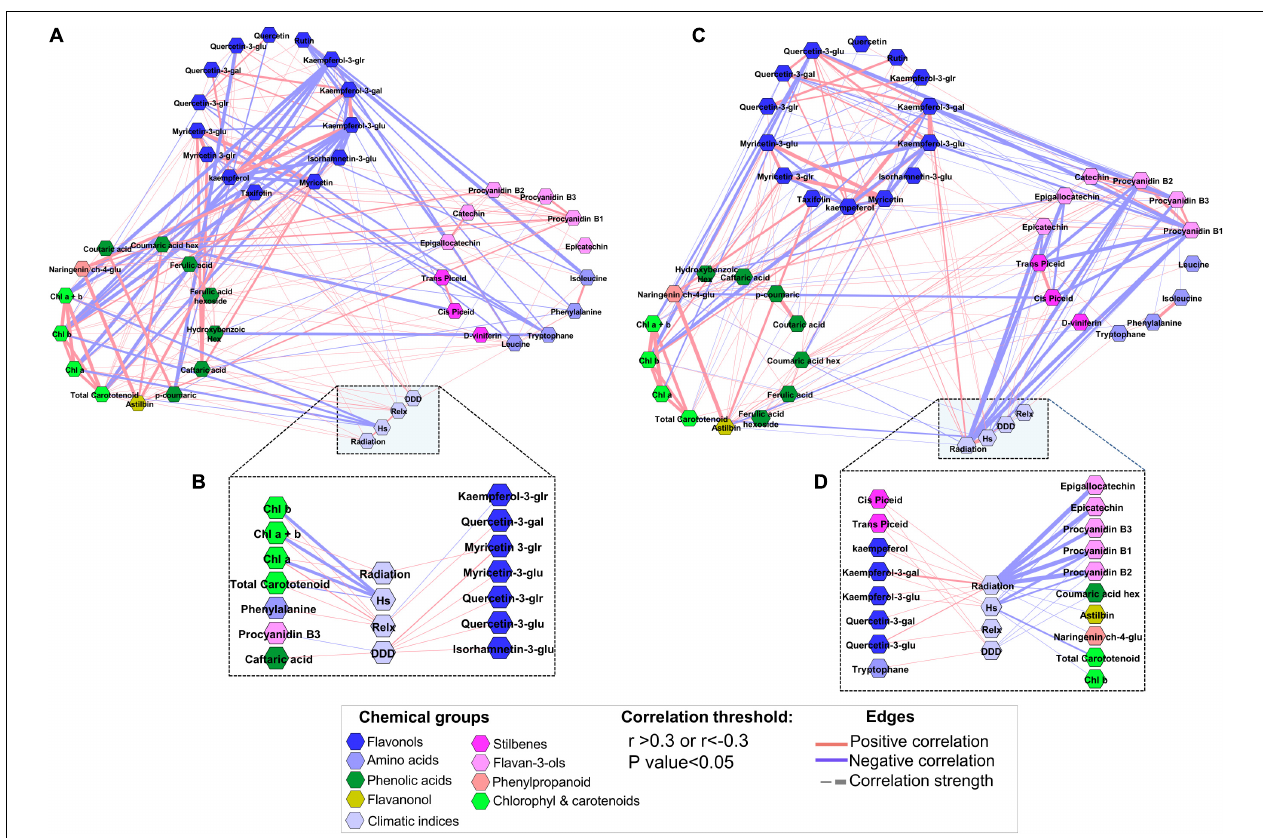
FIGURE 8 | Network visualization of skin phenylpropanoid metabolites as analyzed from ripe white grapevine berries grown at the Mitzpe Ramon (MR) (A) and Ramat Negev (RN) (C) vineyards during 2017–2019. (B,D) Show metabolites significantly correlated with environmental factors (Hs, Relx, and radiation) at MR and RN, respectively. Metabolites are color-coded and clustered according to the chemical groups. Correlation analyses were performed using the mean value of four biological replicates of each cultivar in the 2017, 2018, and 2019 seasons at MR and RN separately; only significant correlations are presented. Positive correlations are shown as red edges, and negative correlations as blue edges. Correlations were based on Pearson’s method. Hs, heat stress degree hours; Relx, relaxation degree